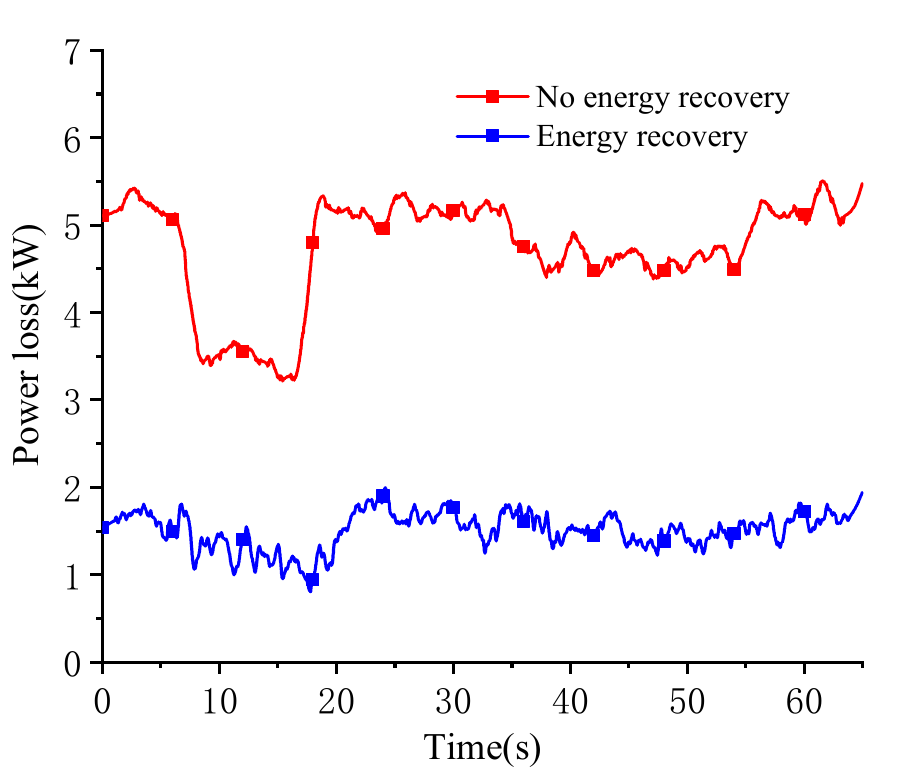
Figure 35. Power consumed in the throttle-governing system with the energy regeneration system.